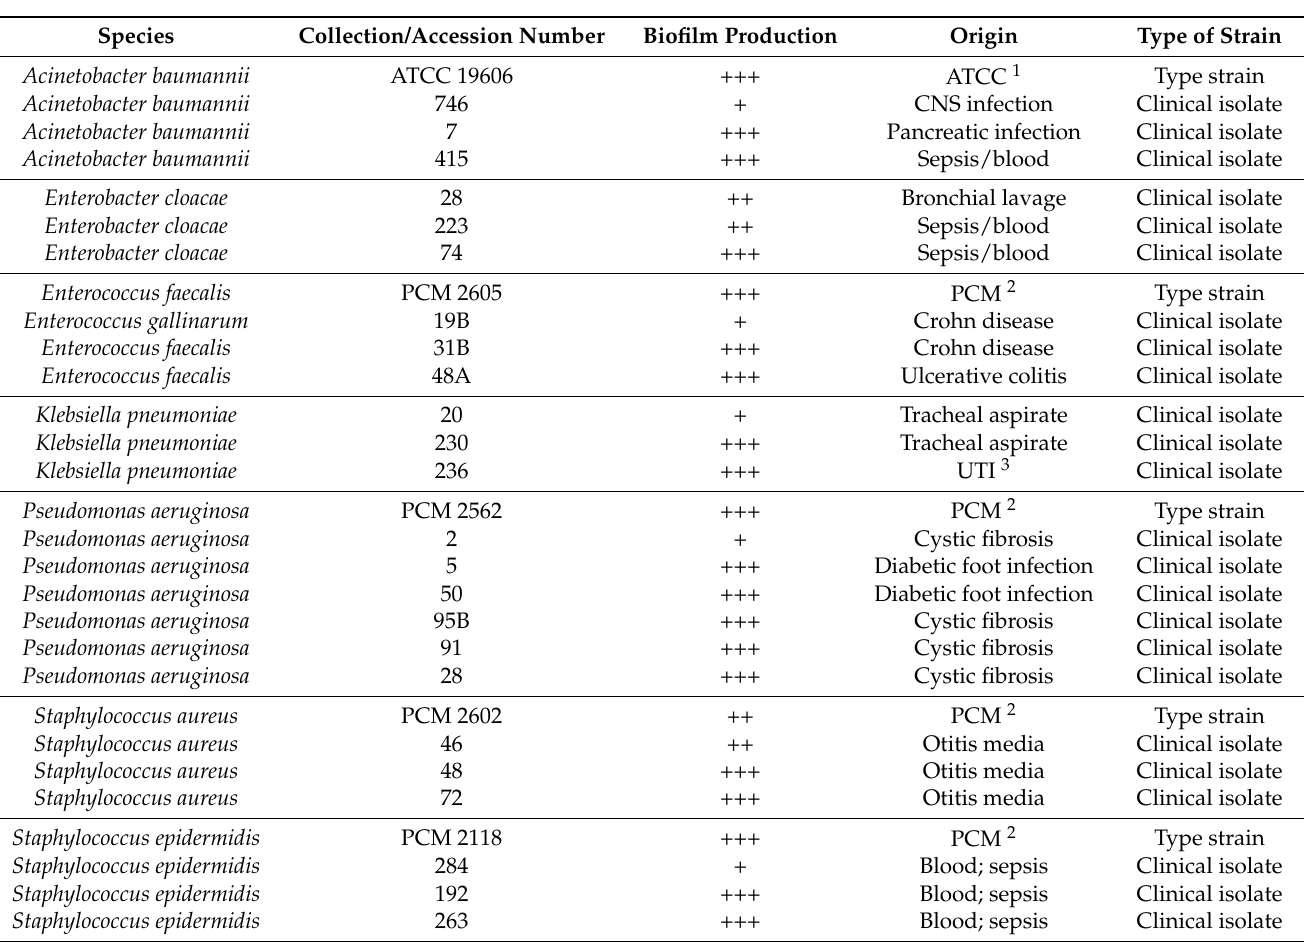
Table 1. Bacterial strains